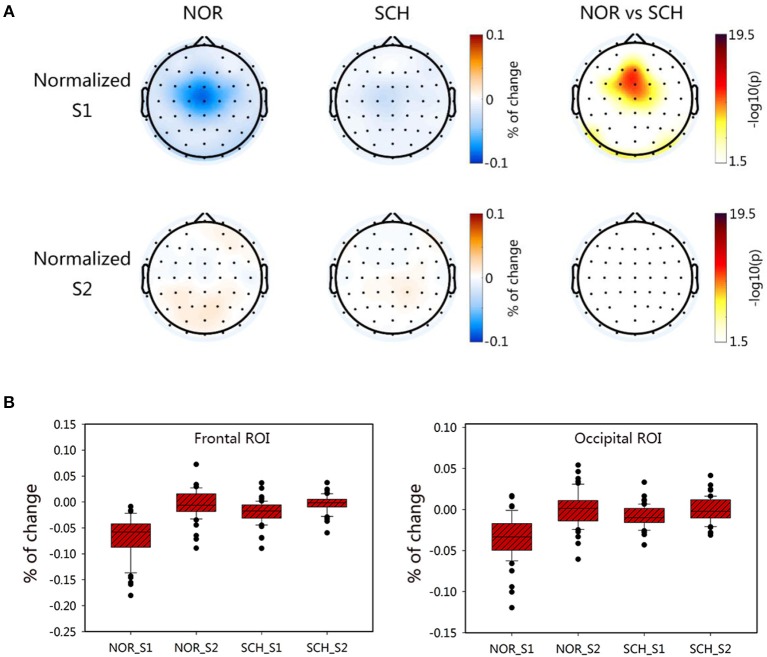
Characteristic distribution of the normalized values for S1 and S2 in each group. Panel (A) shows the topographic map of the normalized values of the two groups. The darker the color was in the first two columns, the greater the value would be. The third column took the logarithm of the p-value of the statistical test; the darker the color was, the greater the difference between groups would be. Panel (B) represents the normalized ROI box plot of the two ROIs.